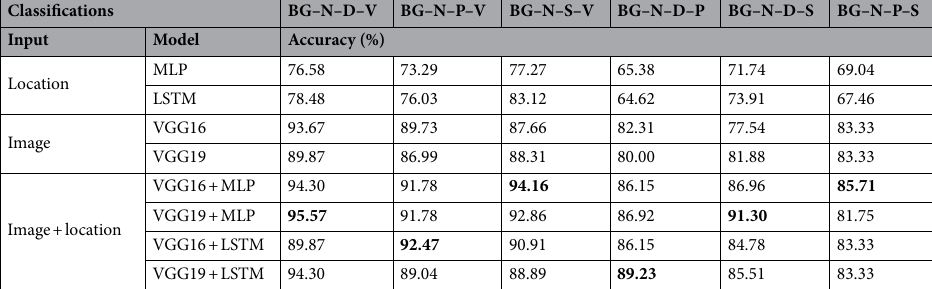
Table 7. Six four-class classifications on AZH dataset. The bold represents the highest results/accuracy achieved for each experiment.